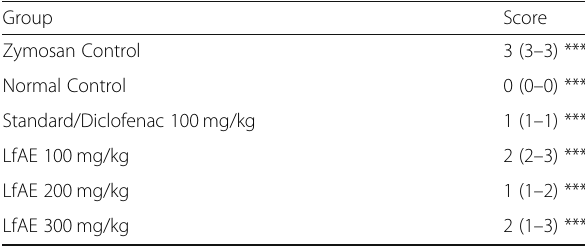
Table 1 LfAE effect (100, 200 and 300 mg/kg) on the histopathological scores according to the experimental groups Group Score Zymosan Control 3 (3 – 3) *** Normal Control 0 (0 – 0) *** Standard/Diclofenac 100 mg/kg 1 (1 – 1) *** LfAE 100 mg/kg 2 (2 – 3) *** LfAE 200 mg/kg 1 (1 – 2) *** LfAE 300 mg/kg 2 (1 – 3) *** *( p < 0.05); **( p < 0.01); ***( p < 0.001) vs zymosan control ( Kruskal-Wallis, Dunn ’ s ). ( n=6